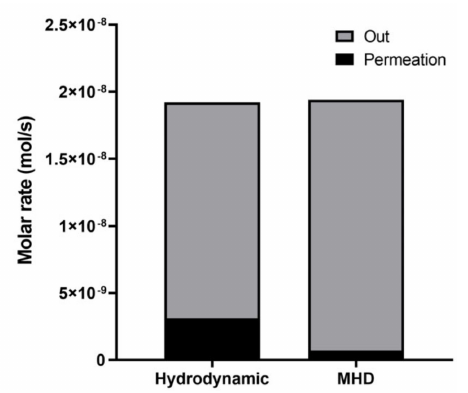
Figure 14. Steady-state molar flux exiting from the BU in PbLi (Out) and permeated through the piping system into the water (permeation) for the two